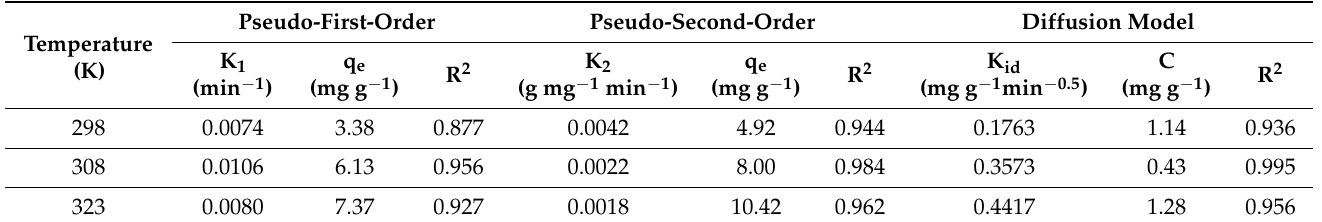
Table 3. Parameters of the pseudo-first and pseudo-second-order kinetic models and the diffusion model (Weber-Morris) at different